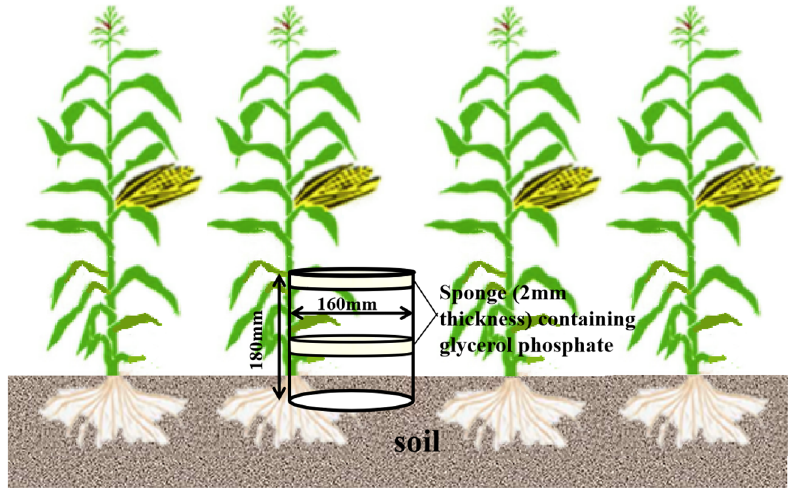
Figure 7. Schematic diagram of NH 3 emission monitoring.